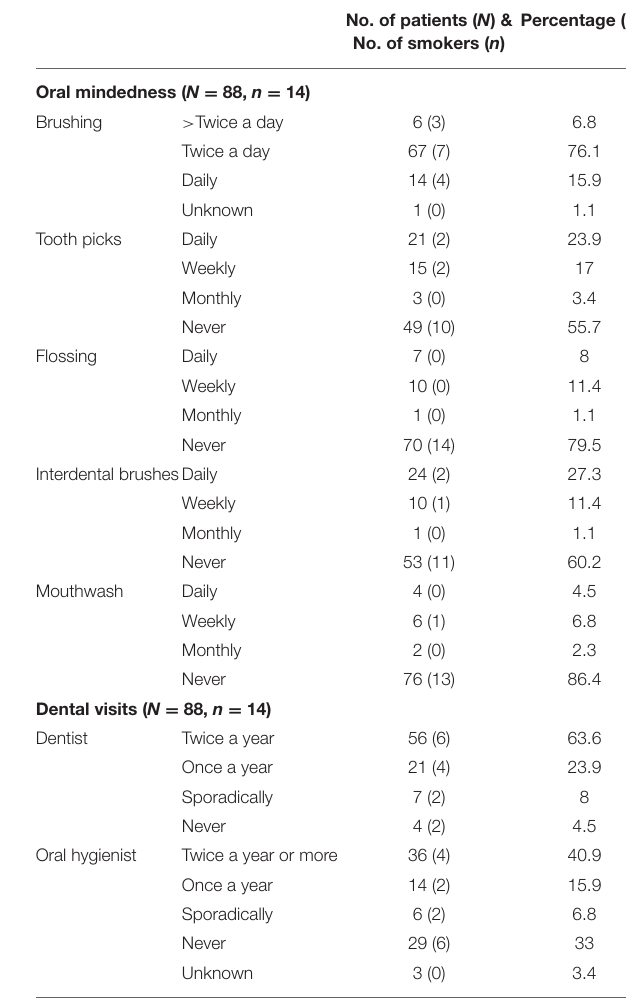
TABLE 1 | Patient demographics, tumor and treatment characteristics. TABLE 2 | Oral mindedness and dental